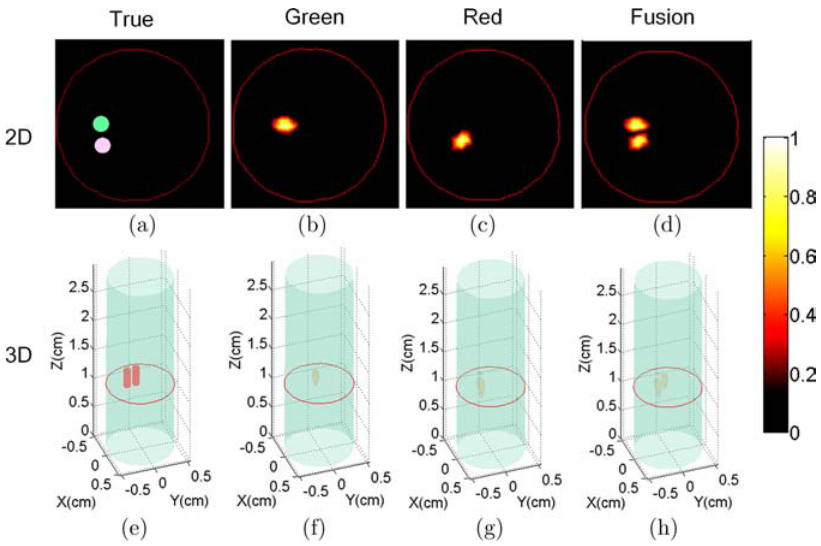
Fig. 8. Resconstruction results of the two single-colored °uorescent objects planted 2.0 mm to the boundary. (a) – (d) Cross-sections at the height of Z = 1.1 cm. (a) Real positions of the two single-colored °uorescent objects in the phantom. The distance between the two capillary quartz tubes is 0.8 mm. Reconstruction results with measurements at the center wavelength of (b) 530 nm and (c) 620 nm, respectively. (d) Fusion image of the reconstructed objects at 530 and 620 nm. (e) Real positions of the two single-colored °uorescent objects in three dimensions. Reconstructed 3D objects with measurements at the center wavelength of (f) 530 nm and (g) 620 nm, respectively, and (h) the fusion result of (f) and (g). The red circles on the cross sections indicate the phantom boundary, while the red circles on the 3D images indicate the position of cross